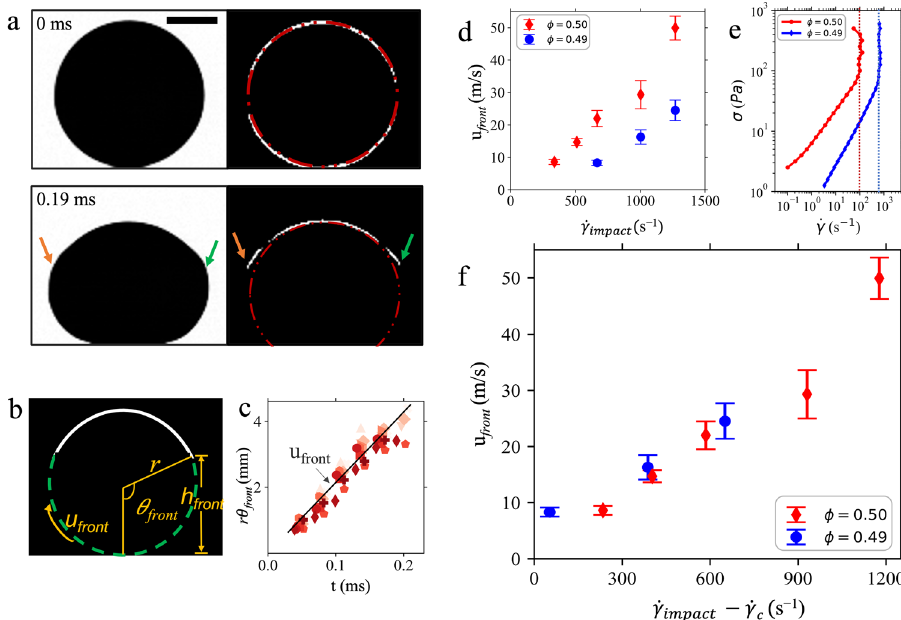
Fig. 6 Dynamics of the solidi fi cation front. a Timeseries of a ϕ = 0.50 drop impacting at u 0 = 2.0 m/s [Video SI6 27 ]. Right panels are images obtained by subtracting consecutive frames, so that the edge of the solidi fi cation front is highlighted (shown by arrows).The red circle indicates the drop pro fi le before impact. Even at 0.19 ms, the portion of the drop above the front maintains its pre-impact curvature. Scale bar is 1 mm. b Schematic of a subtracted image of the moving solidi fi cation front, outlining relevant parameters. The height, h front , of the edge of the white outline gives the location of the front, which is then converted to r θ front using the spherical geometry. c Example datasets of r θ front vs. t for ϕ = 0.49 and u 0 = 3 m / s . r θ vs. t is a straight line, the slope being the front speed along the surface, u front . d u front plotted against _ γ impact . e High- ϕ bulk rheological data from Fig. 1b re-plotted as shear stress vs. shear rate. Dotted lines indicate the onset shear rates _ γ c for shear thickening. f The u front data for ϕ = 0.49 and ϕ = 0.50, when plotted against _ γ impact (cid:2) _ γ c , collapses on a single curve. In all panels, error bars indicate one standard deviation over at least 5